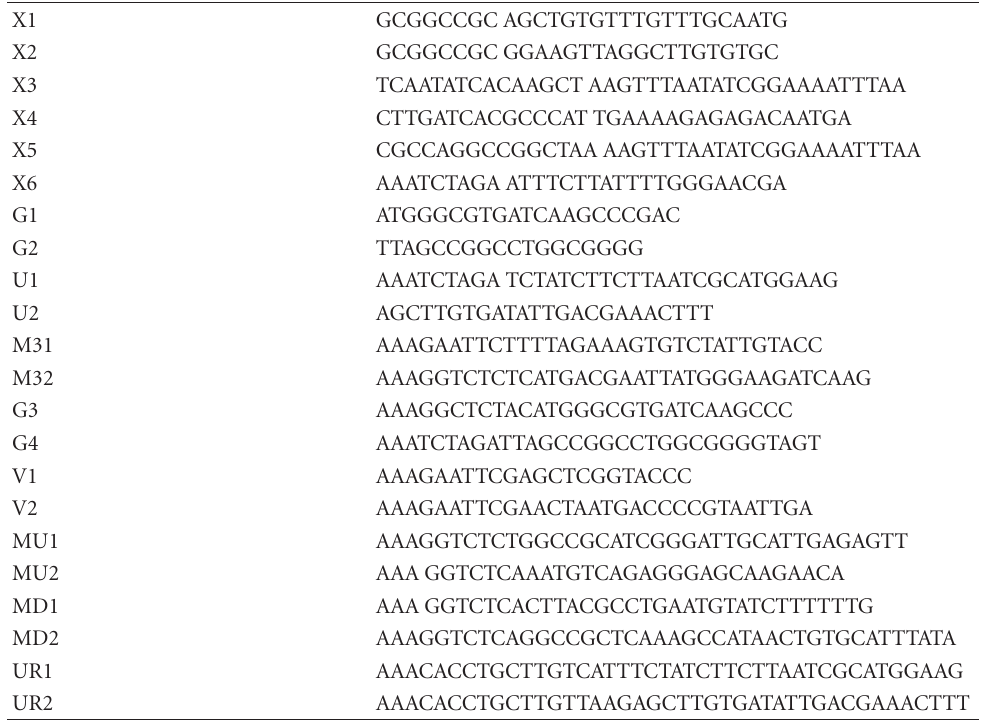
Table 2: List of primers used in this